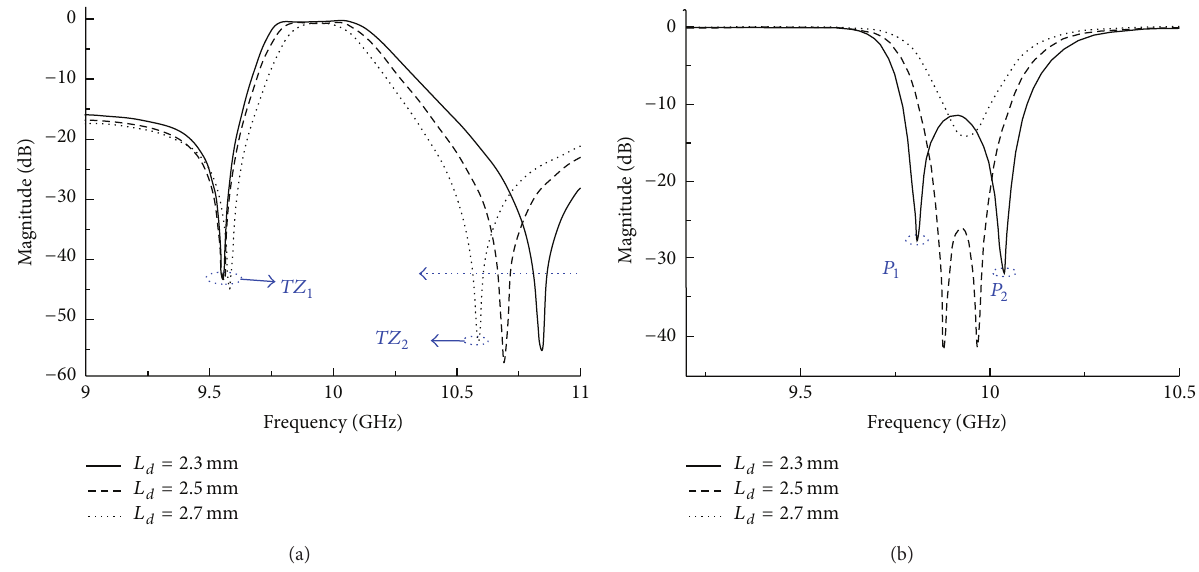
Figure 5: Frequency response for different values of 𝐿 𝑑 : (a) 𝑆 21 and (b) 𝑆 11 .